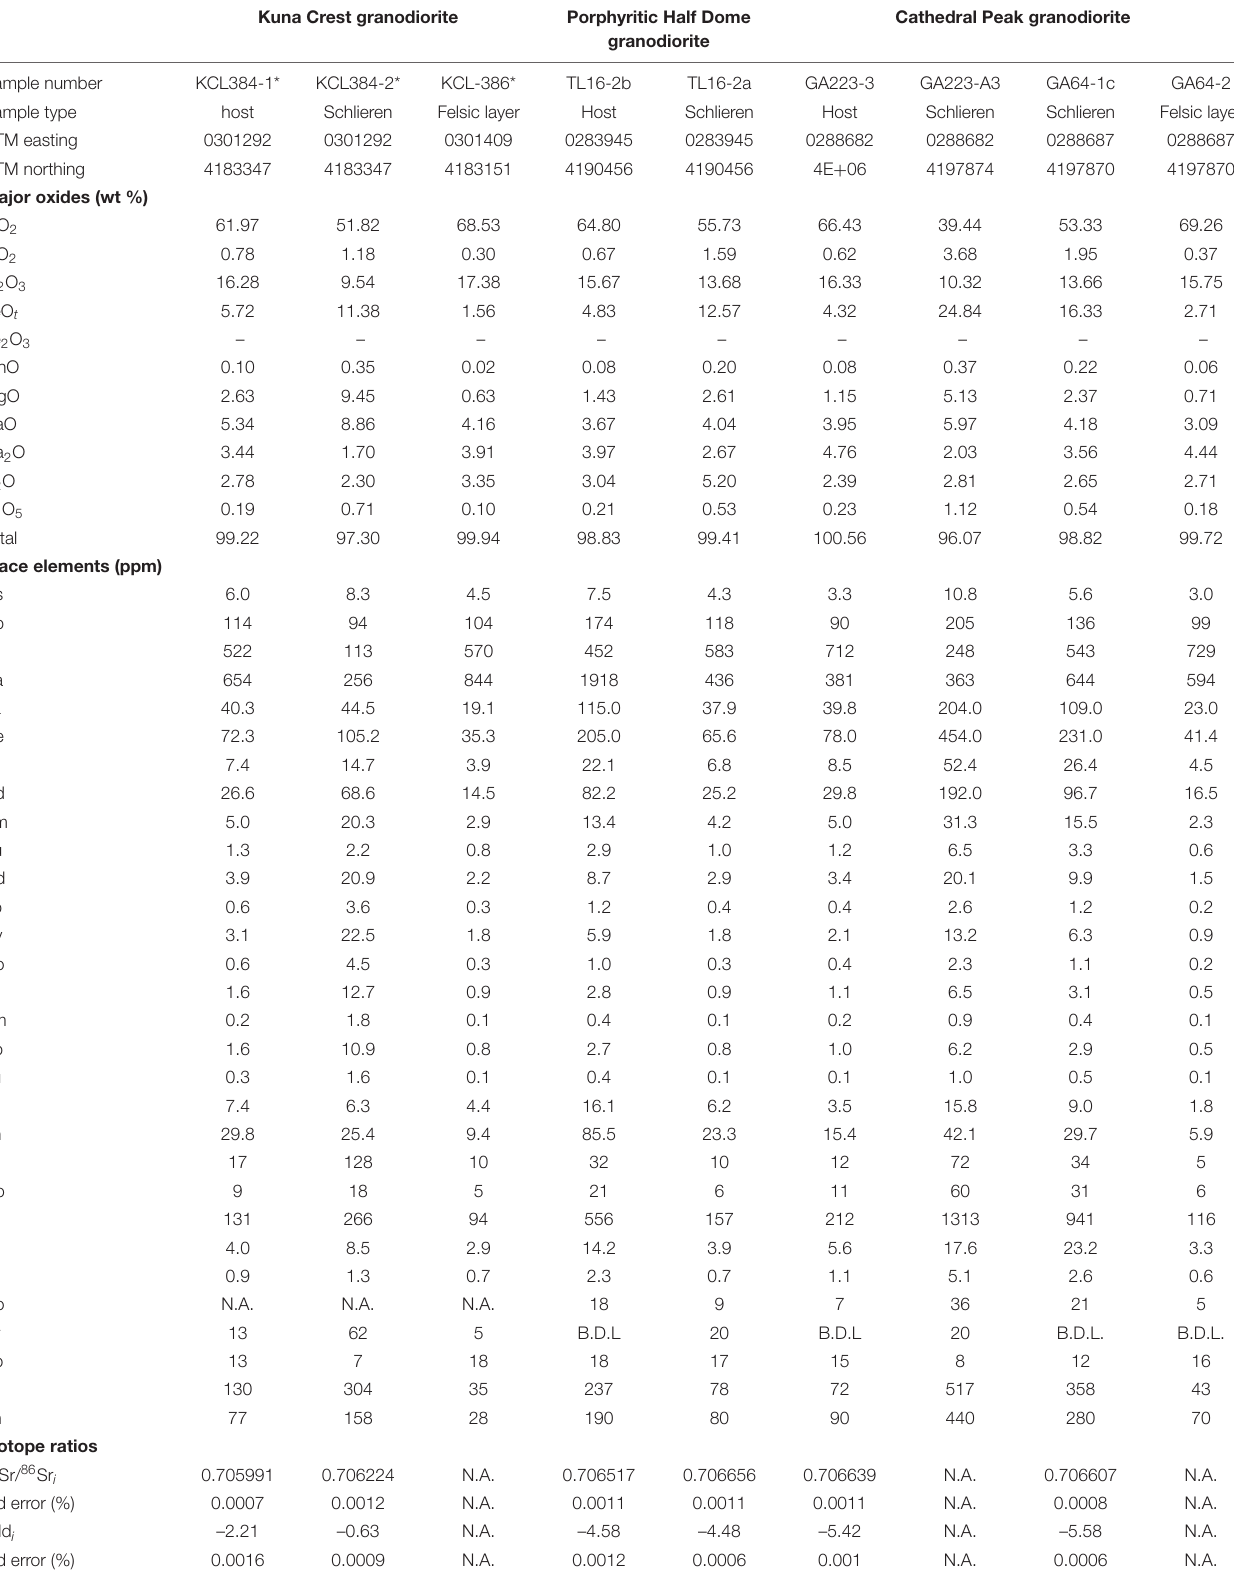
TABLE 2 | Whole-rock geochemistry for representative schlieren, host, and felsic samples. Kuna Crest